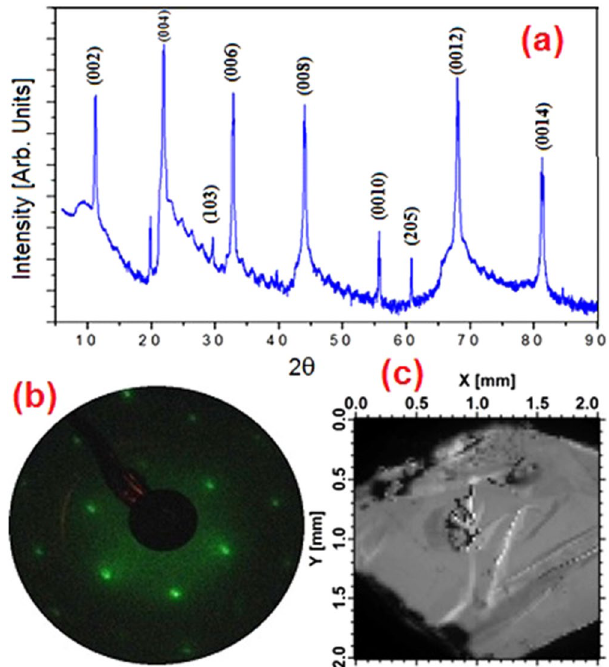
pattern of the as-cleaved sample of β -InSe, acquired at a primary electron energy of 100 eV; ( c ) Topographic map of the photoemission signal of as-cleaved β -InSe at the Γ point of the